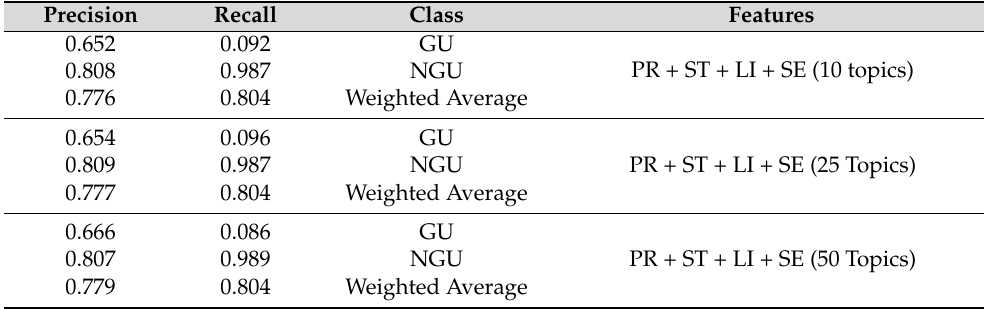
Table 8. The precision and recall of Random